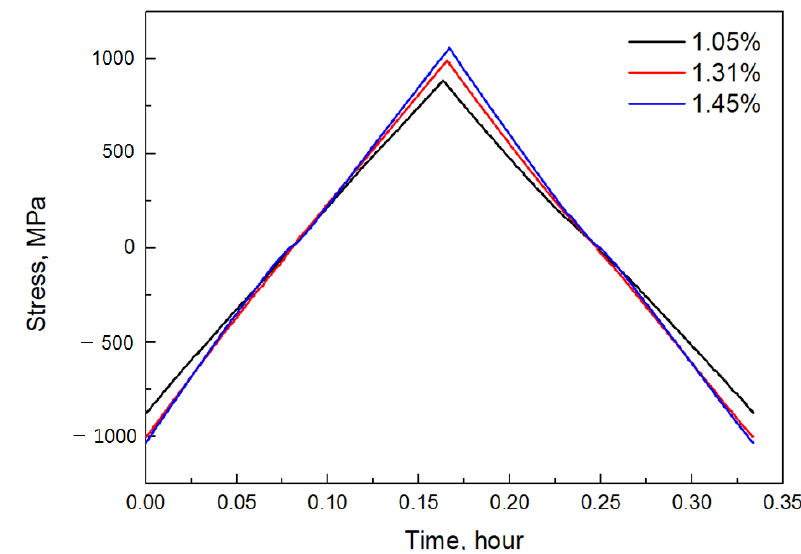
Figure 8. Variation in stress with time at 800 °C.